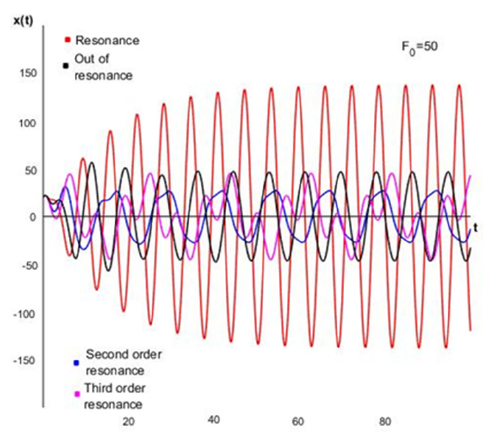
Figure 4. Position vs. time plot for systems with different degrees of resonances, subjected to loading expressed by Equation (6). Reproduced from [13], Published by IOP Publishing 2017.